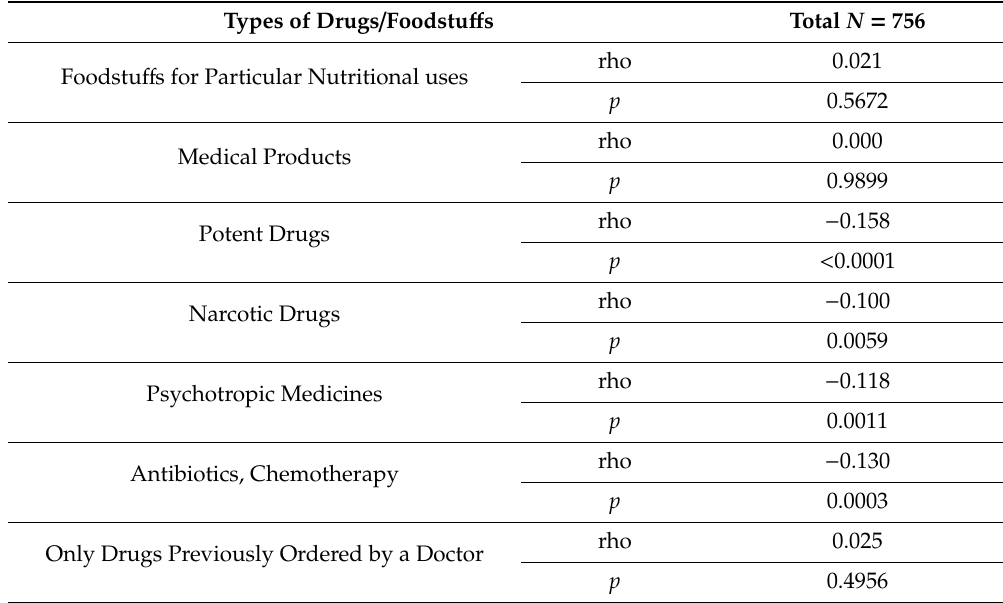
Table 3. Readiness to administer drugs / agents depending on the age of the